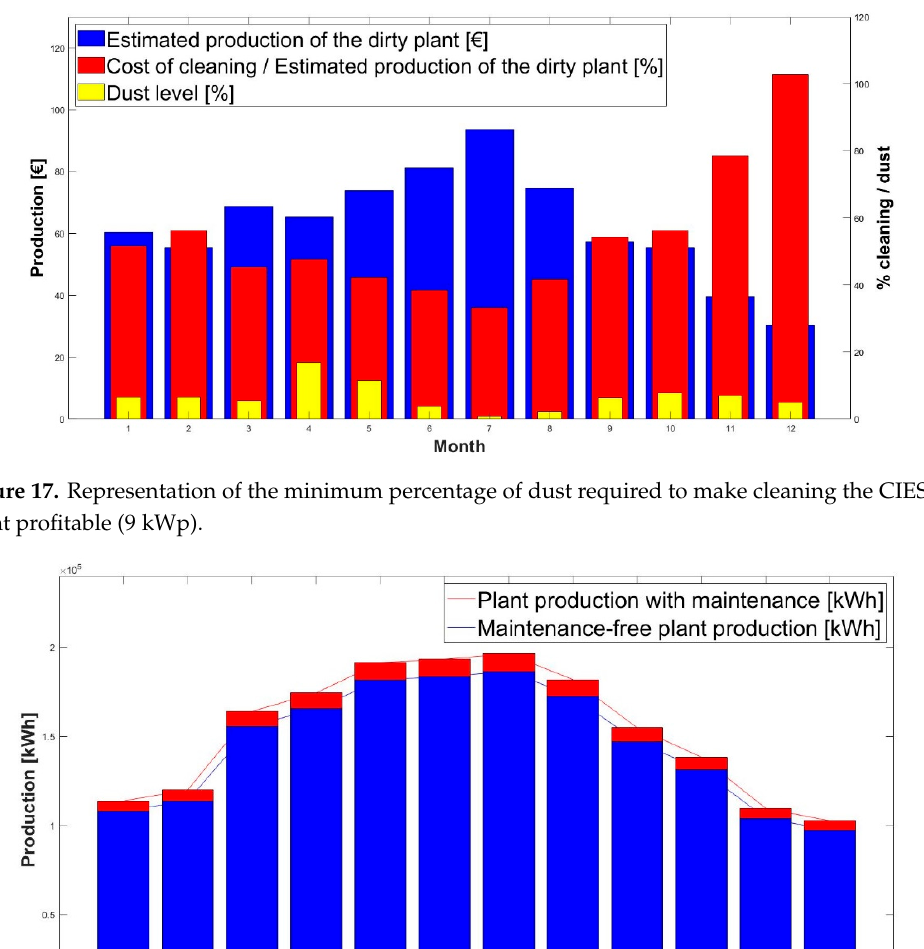
Figure 17. Representation of the minimum percentage of dust required to make cleaning the CIESOL plant profitable (9 kWp).